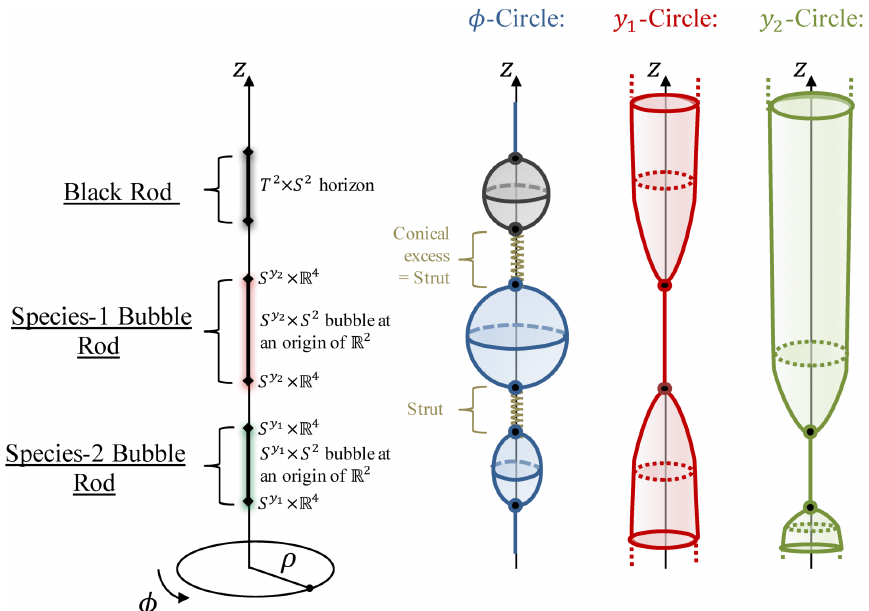
Figure 10. Schematic description of the three possible categories of physical rods and the behavior of the circles on the z -axis. The black rod sources a two-dimensional static black brane with a T 2 × S 2 horizon. The species-1 bubble rod corresponds to the degeneracy of the y a S y 2 × S 2 bubble and reversely for the species-2 bubble rod. Each section between sources has a conical